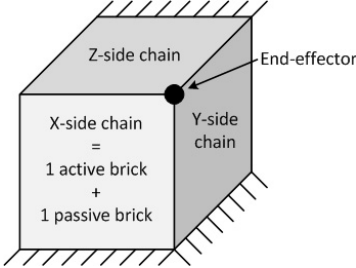
Figure 2. Symbolism of the parallel robot designed with the mod- ular